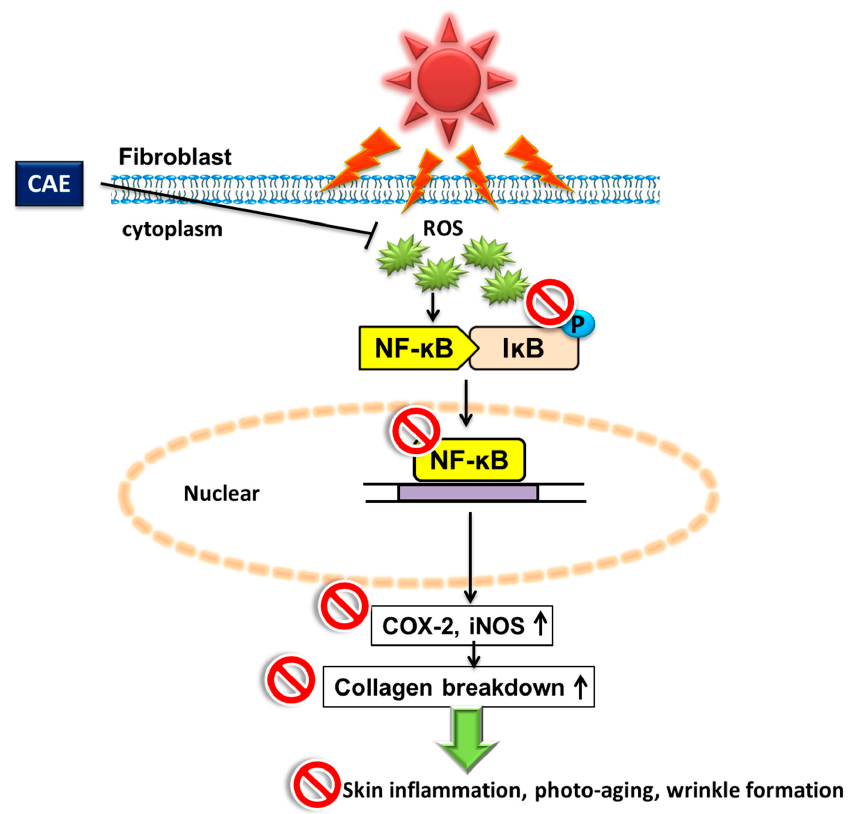
Figure 21. Scheme of CAE inhibition of UVB-induced inflammation and photodamage. ( ↑ : upregulation;